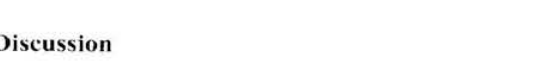
The cells were incubated in the presence or absence of 1 μΜ SP for 18 h and then irradiated with various doses of γ-rays. MN frequencies were increased by γ- rays in a dose-dependent manner between 0 and 1 0 Gy. reaching a plateau at more than 10 Gy. Pretreatment induced by γ-rays at doses of between 5 and 1 5 Gy (Fig. 4).